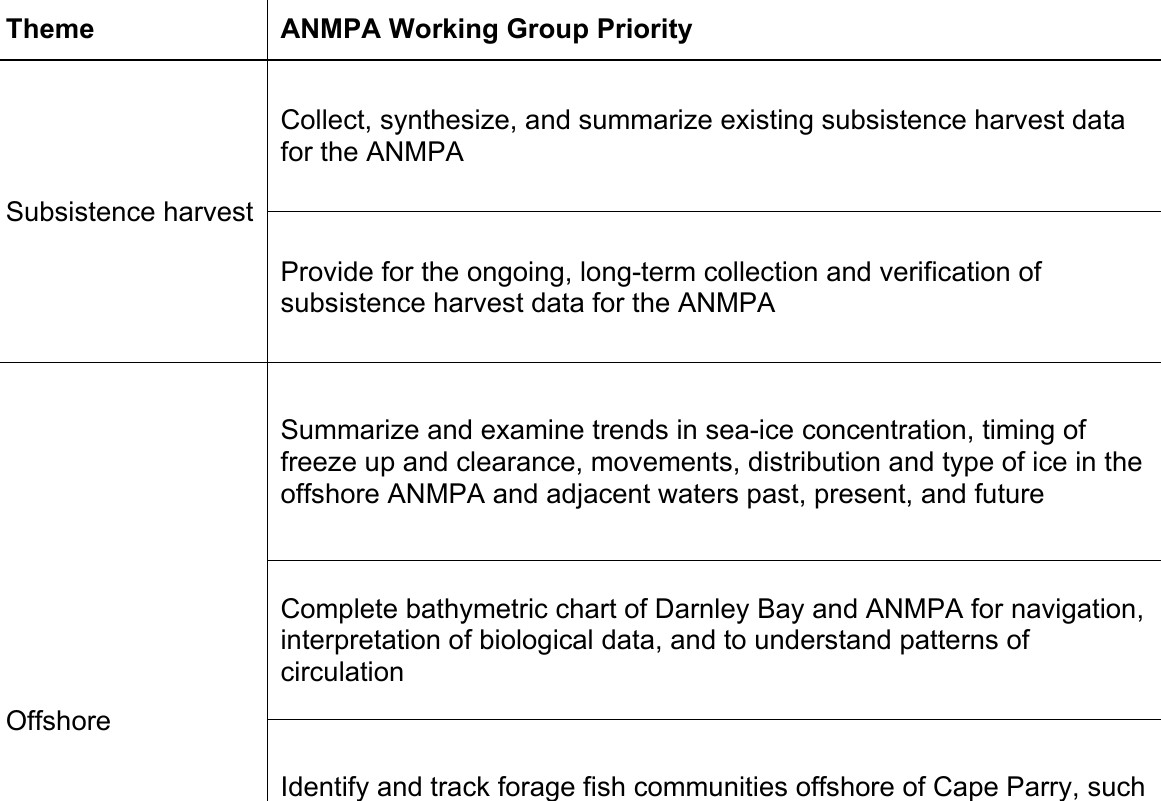
Table A1. Monitoring priorities provided by the ANMPA Working Group to inform discussions of ecological monitoring